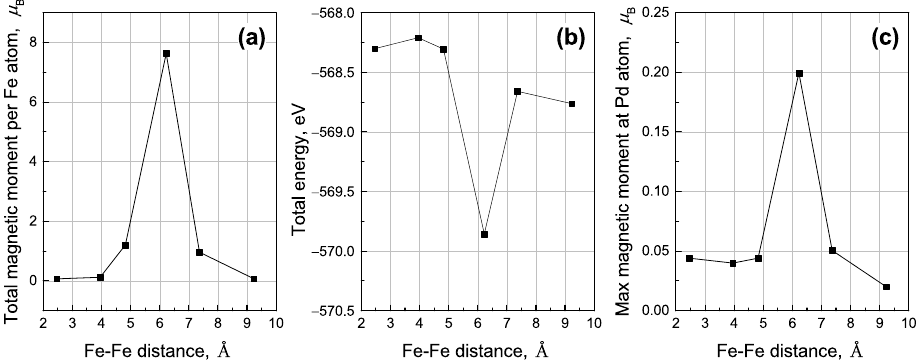
Figure 4. ( a ) Total magnetic moment calculated per Fe + ion plotted against Fe to Fe distance; ( b ) total energy of the 3 × 3 × 3 Pd supercell; ( c ) maximal magnetic moment at Pd atom. Two substitutional Fe atoms in the host matrix cell were considered. Each point was obtained by averaging over at least three configurations when Fe atom substitutes for Pd in different lattice sites but at the same interatomic